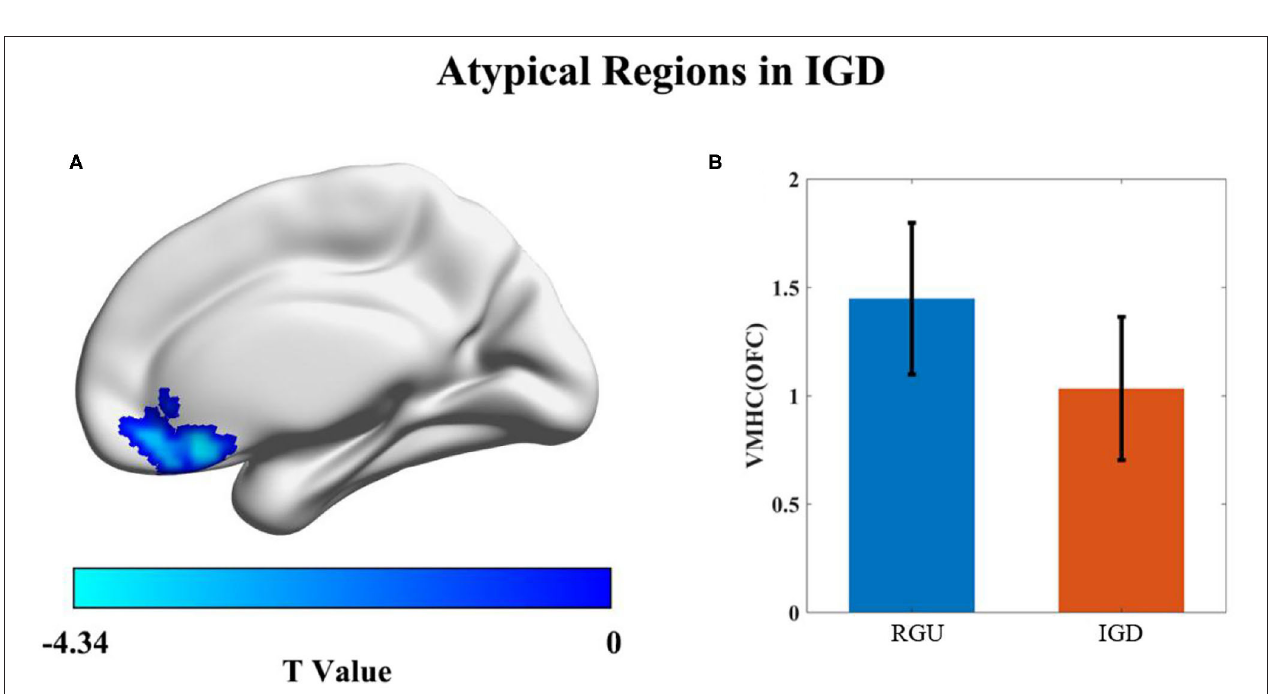
FIGURE 2 | Differences in VMHC value between the IGD and RGU groups durinresting state. p < 0.05 (AlphaSim correction). Voxel size = 3 × 3 × 3 mm 3 , the blue color represents the VMHC decreased area in the IGD group compared with the RGU group (A) . Histogram (B) shows the mean and standard deviation of VMHC values in the two